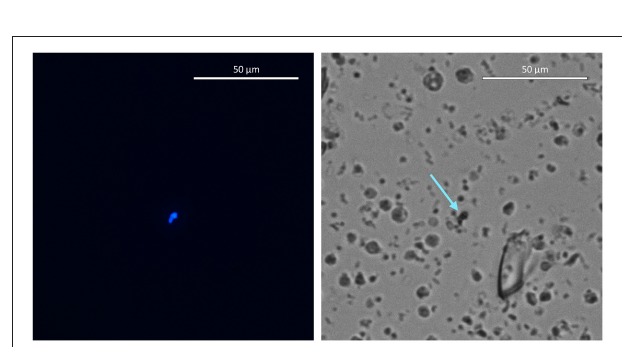
FIGURE 5 | Blue fluorescing cells in images taken with DAPI (Left) and transmitted light (Right) filters at 80x magnification. Arrow indicates the cells that fluoresce blue in the DAPI filter